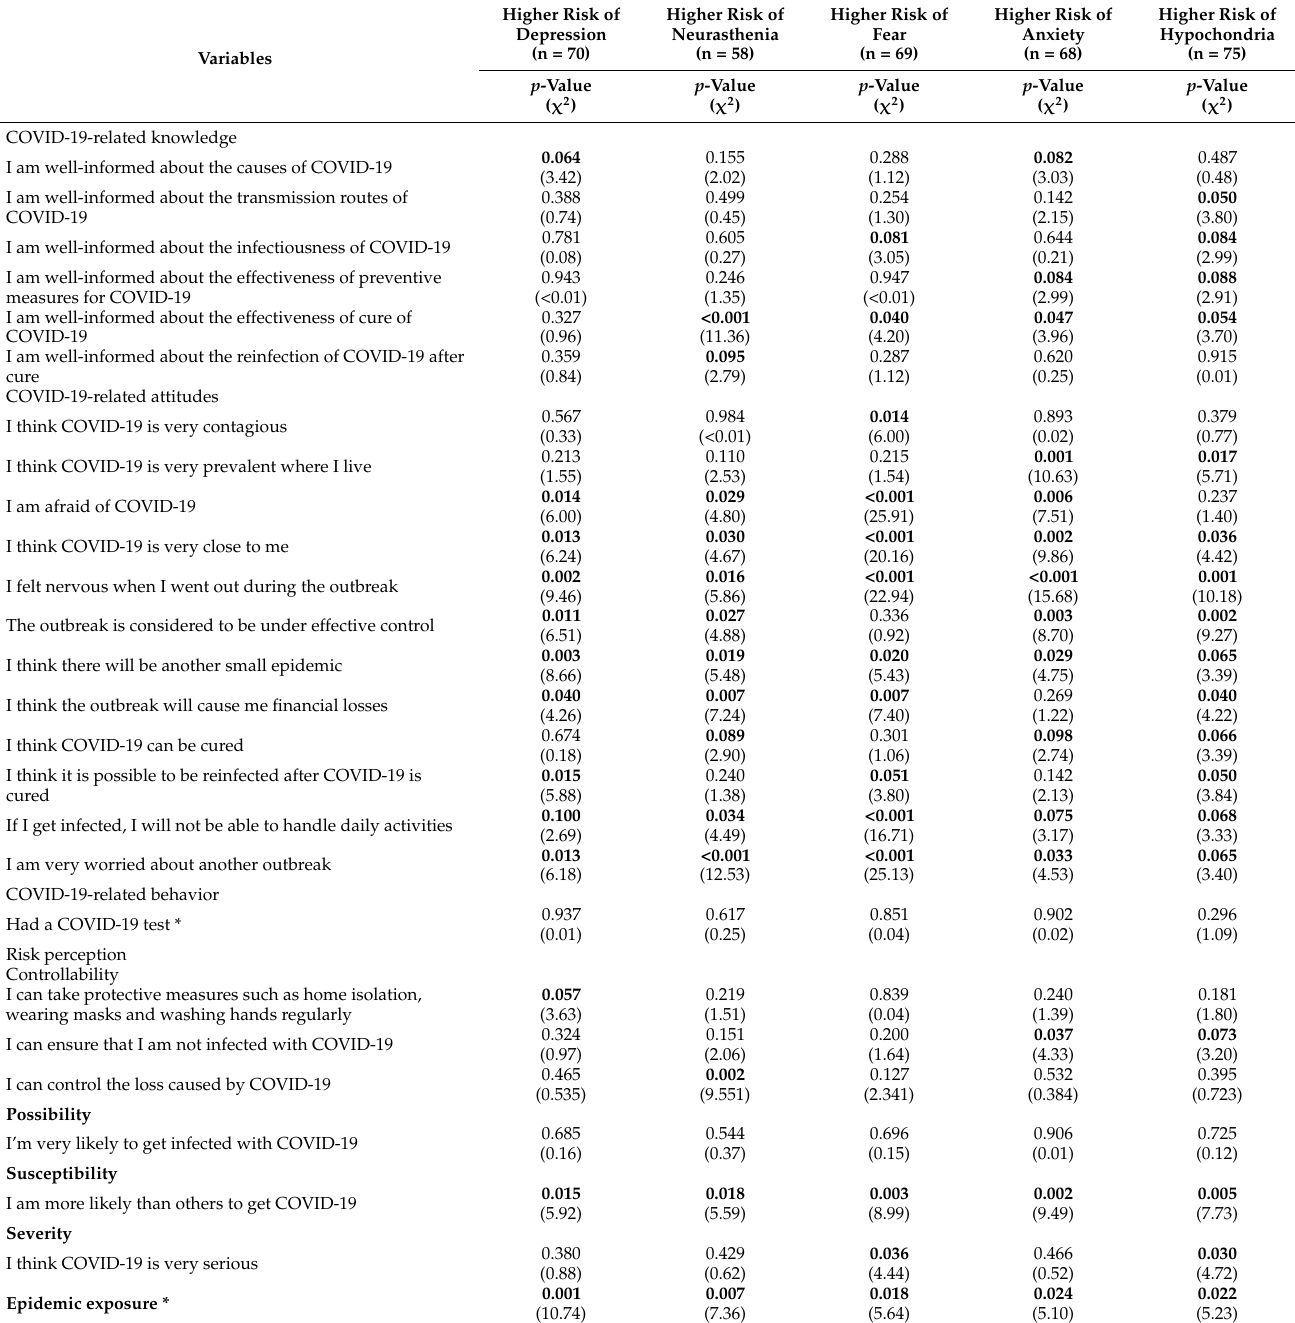
Table 4. Univariate analysis of participants’ COVID-19-related characteristics using five subscale high-risk scores of the PQEEPH (n =